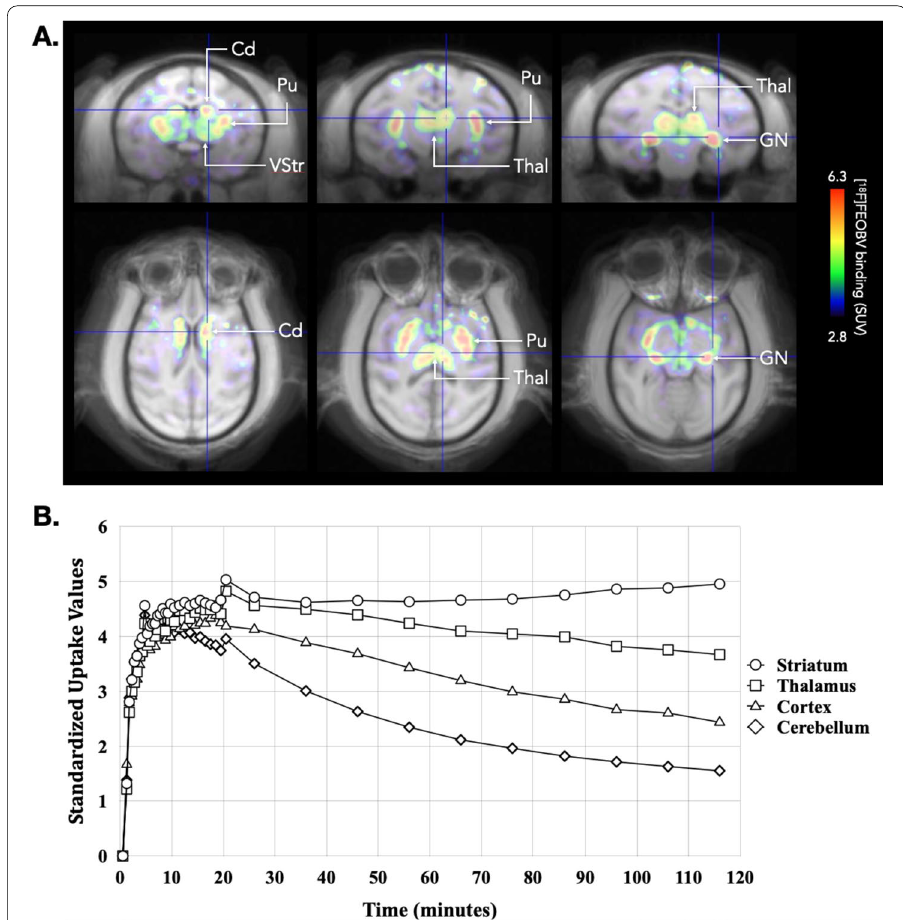
Fig. 7 A Fusion between MRI and (‑)‑[ 18 F]FEOBV SUV images (average between 80 and 120 min) showing the (‑)‑[ 18 F]FEOBV binding in the striatum, thalamus and geniculate nuclei on representative coronal and horizontal brain slides. B Time‑activity curves of (‑)‑[ 18 F]FEOBV binding in the striatum, thalamus, cortex and cerebellum. Cd caudate, GN geniculate nuclei, Pu putamen, Thal thalamus, VStr ventral